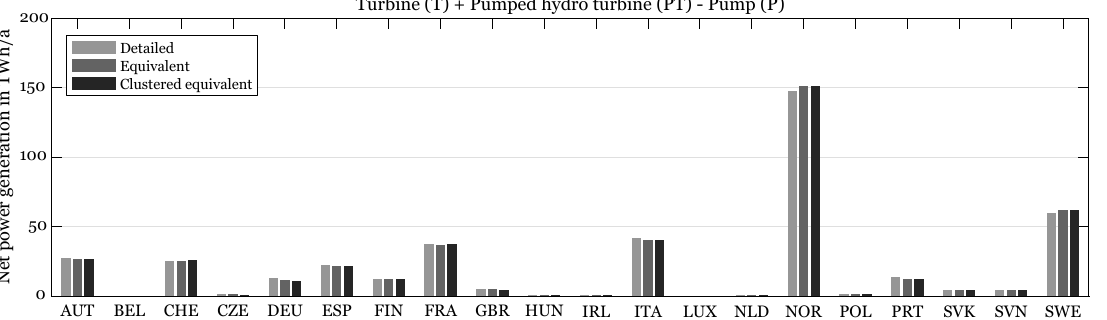
Figure 7. Annual sum of net hydropower generation of detailed, equivalent, and clustered equivalent hydro system models in all considered market areas.